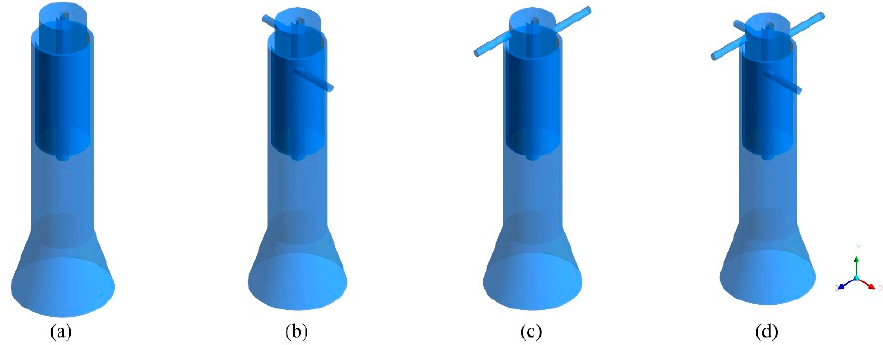
Figure 2. Physical models of RF thermal plasma torch: ( a ) Case A, ( b ) Case B, ( c ) Case C, ( d ) Case D.